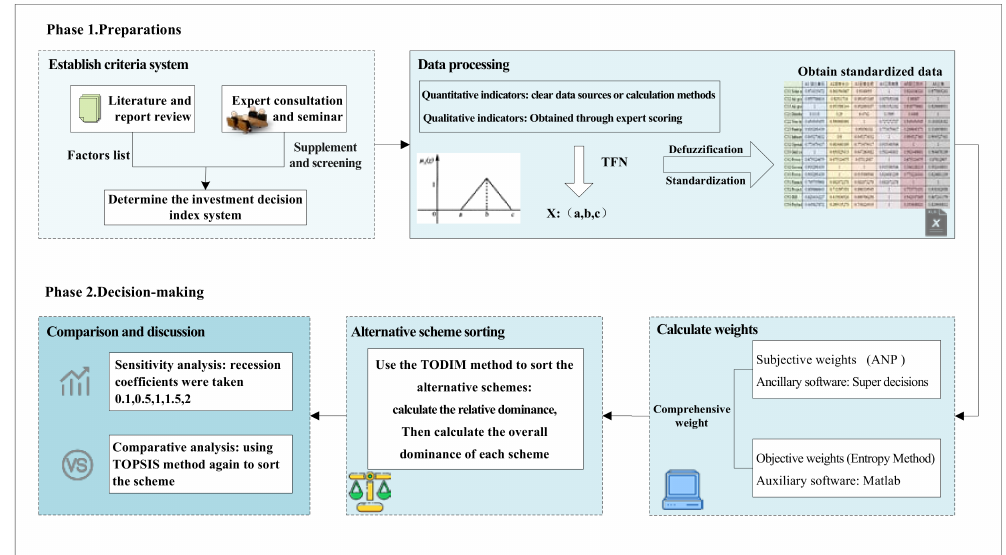
Figure 4. Decision-making Framework for EPC-DPV